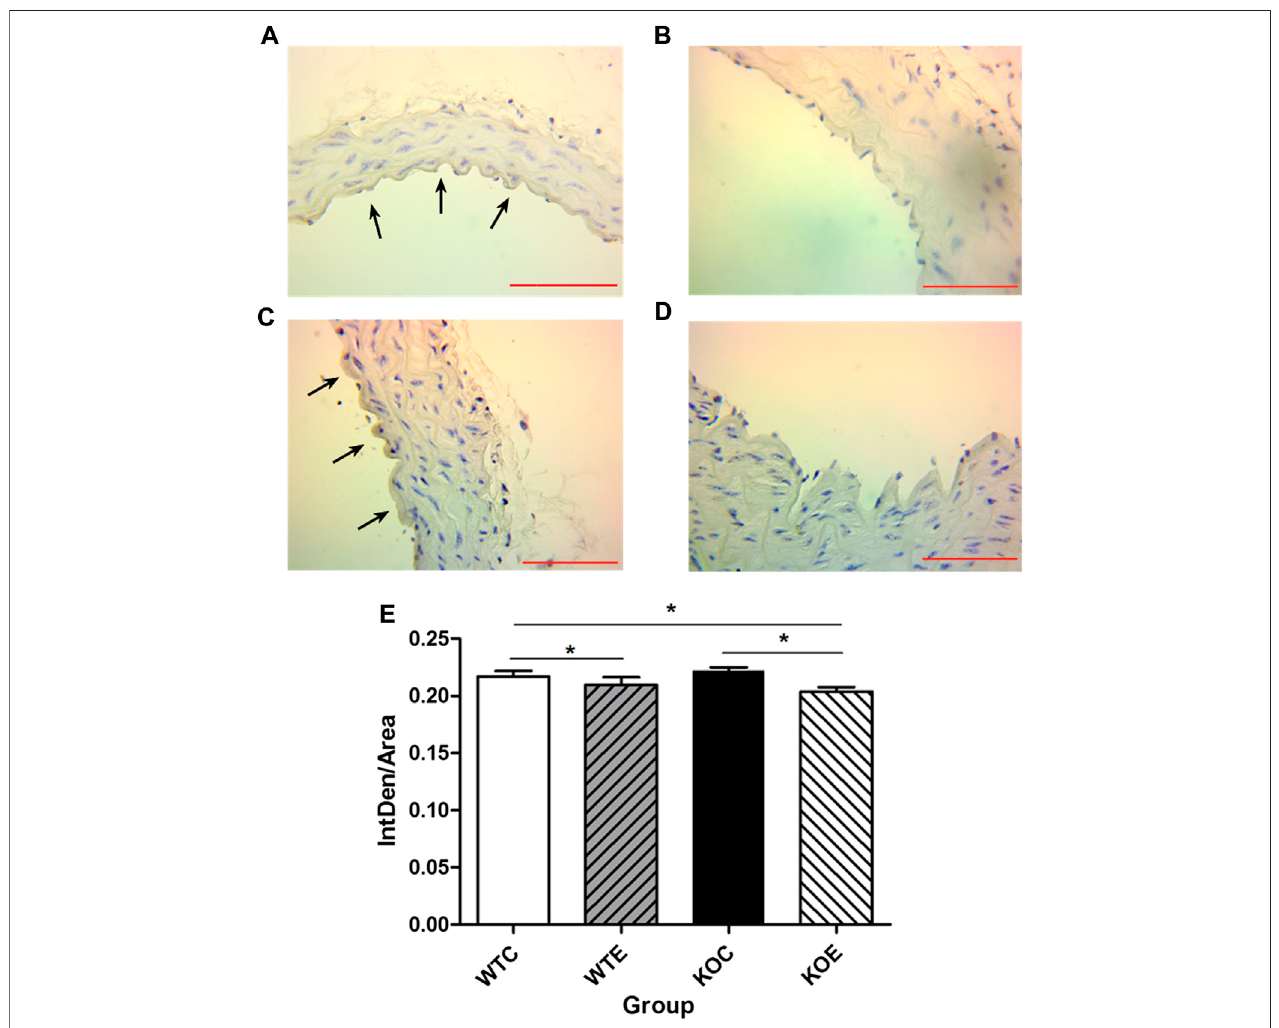
FIGURE 4 | Immunohistochemistry Results of AT1R 6 – 8 weeks C57/B6 mice, with or without Nrf2 knockout were exposed to either fi ltered air or air containing particulate matter (PM) for six weeks, and then the vascular tissues were collected,embedded in paraf fi n and subjected to immunohistochemistry for AT1R. N (cid:2) 6 per group. WTC was C57 wild-type control group, WTE was C57 wild-type PM exposure group, KOC was Nrf2-/- group control group, and KOE was Nrf2-/- group PM exposuregroup.Scalebarsare1,000 μ m,andmagni fi cationis × 400.*:statisticallydifferentbetweenthetwogroups( p < 0.05). (A) :ImmunohistochemistryResults of AT1R in WTC group. (B) : Immunohistochemistry Results of AT1R in WTE group. (C) : Immunohistochemistry Results of AT1R in KOC group. (D) : Immunohistochemistry Results of AT1R in KOE group. (E) : Quanti fi cation of the AT1R expression.